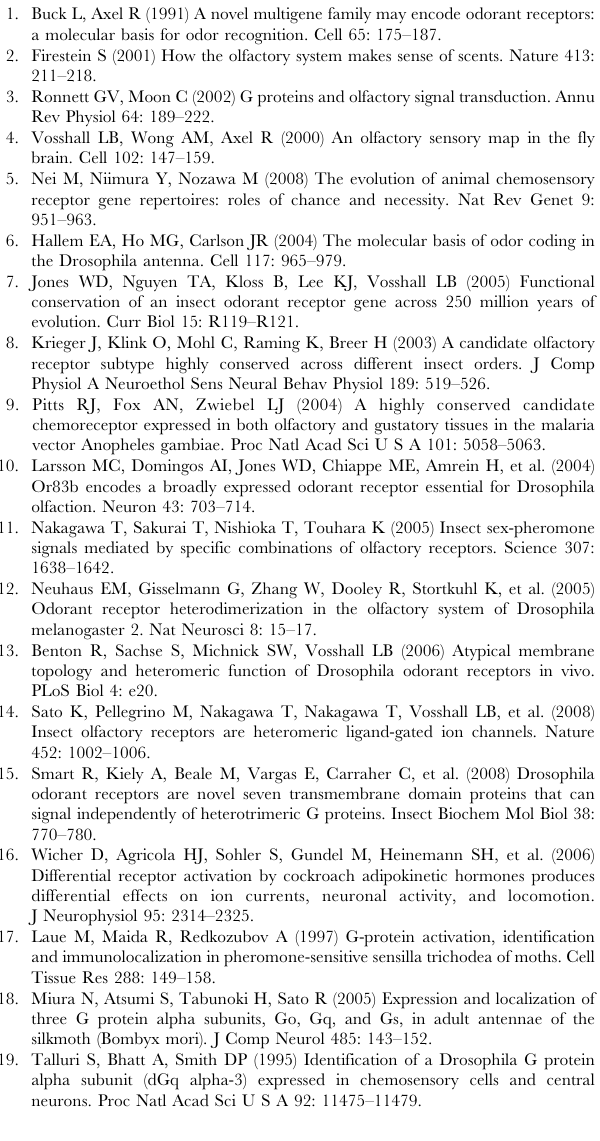
Table S2 EAG measurements on mutant flies (Results of Figure